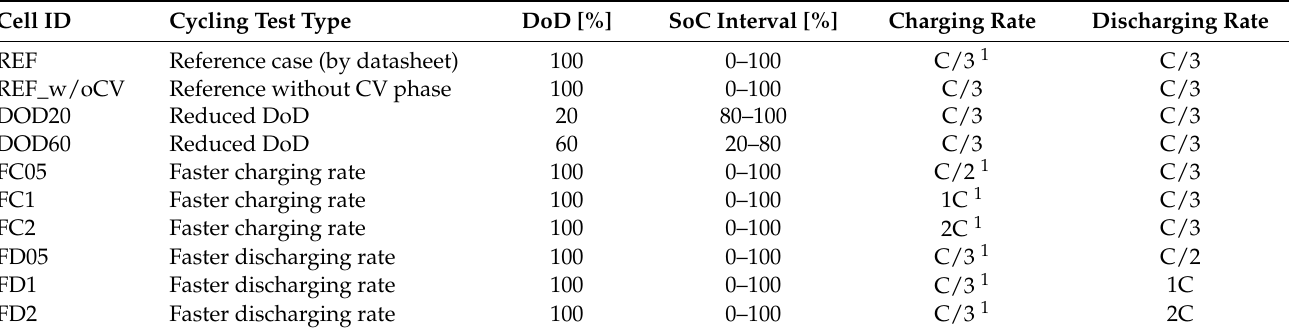
Figure 1. Overview of equipment and cells in Sustainable Energy Center laboratory at CSEM: ( a ) Biologic BCS815 Battery tester; ( b ) ATT-DM1200T Thermostatic chamber and; ( c ) NMC 811 cells under investigation inside the thermostatic chamber. Table 2. Overview of cycling aging testing protocols applied to commercial Li-ion cells. The cycling test type is compared to the reference case (1st row).